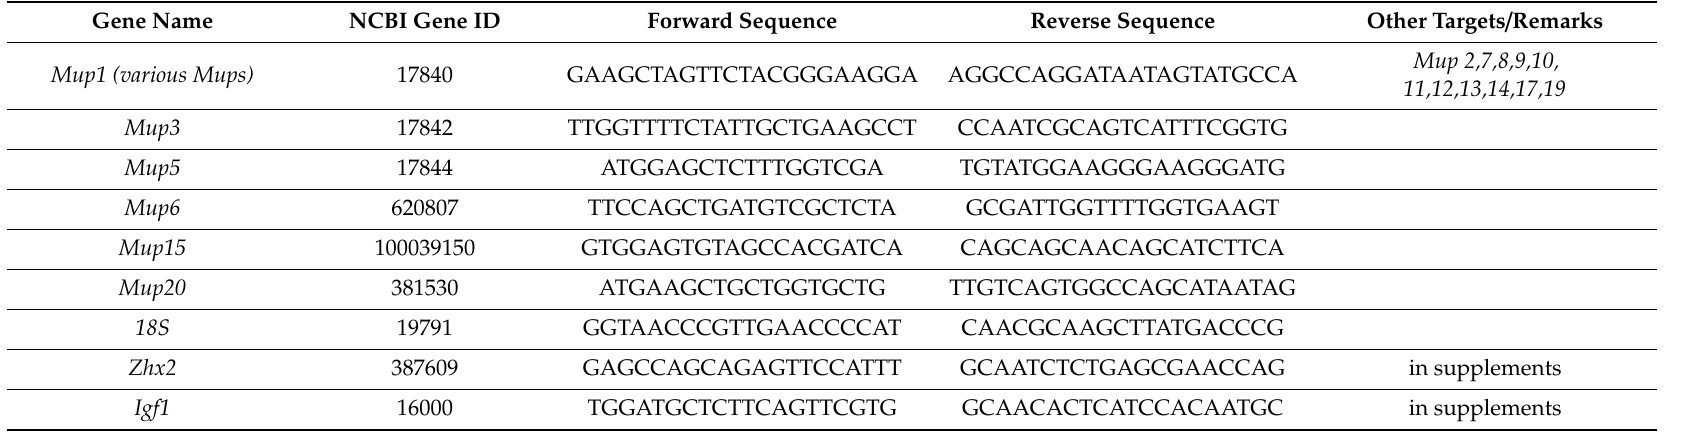
Table 2. Primers used for